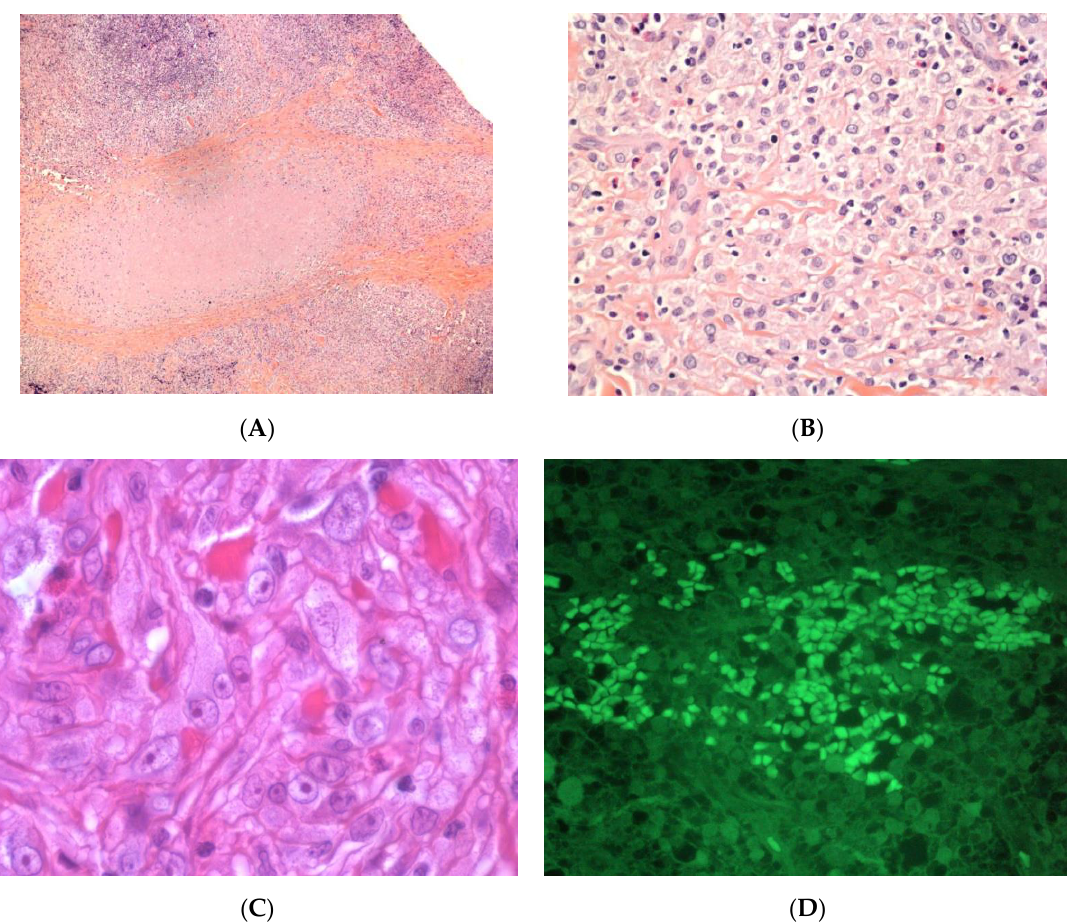
Figure 8. Subcutaneous aluminium granuloma. ( A ) Dense, deep dermal and subcutaneous nodular infiltrate surrounding areas of necrosis (original magnification × 80). ( B ) Mixed infiltrate of lymphocytes, histiocytes, and eosinophils (original magnification × 250). ( C ) Histiocytes containing violaceous granular within their cytoplasm (original magnification × 400). ( D ) The granules stain positive with aluminon staining (Morin, (original magnification × 200)), which reveals the existence of